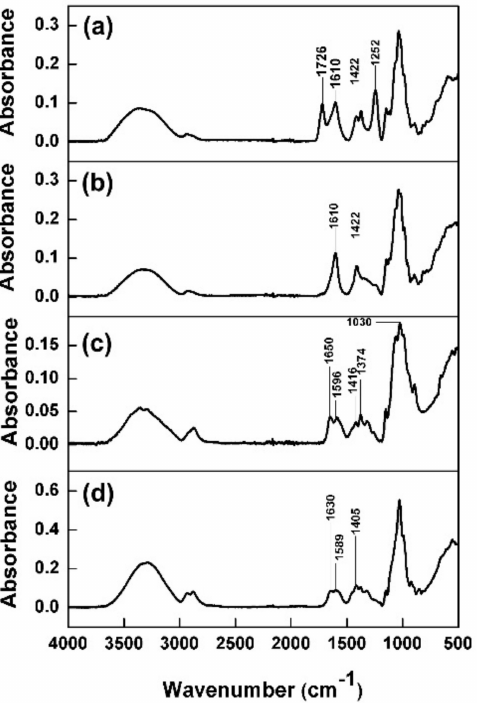
Figure 2. Attenuated total reflection-Fourier transform infrared (ATR-FTIR) spectra of ( a ) native Kg, ( b ) deacetylated Kg, ( c ) Ch, and ( d ) Kg-Ch sponge.